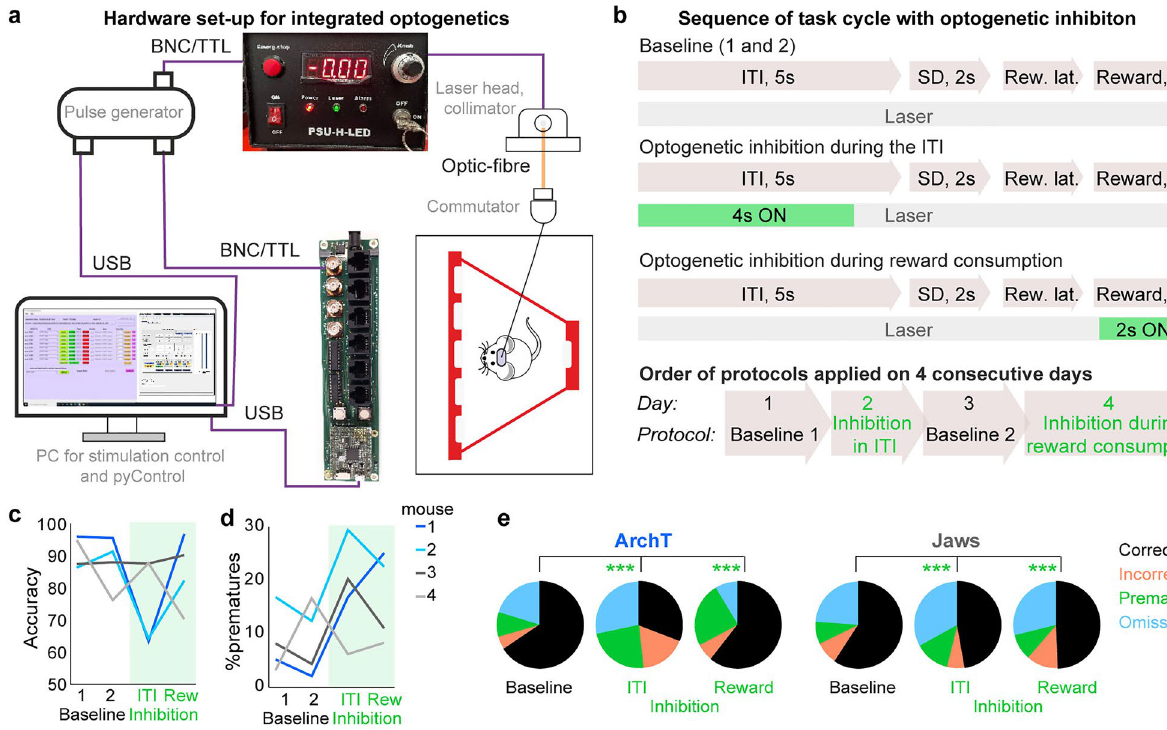
Figure 8. Integration of behavioural testing with optogenetics. ( a ) Wiring scheme for controlling a pulse generator and connected laser from pyControl through a BNC/TTL-output from the breakout board. (The hardware definition file for this arrangement is identical to that shown in Fig. 7b.) ( b ) 5-CSRTT task-cycles (illustrated for the case of a correct response) with either no optical stimulation (baseline sessions 1 and 2), unilateral optical modulation of the dHC during the first 4 s of the ITI or during the first 2 s of reward collection (from top to bottom). Below, the order in which the four protocols were conducted is shown. ( c,d ) Attentional accuracy (c) and premature responding (d) of each mouse (colour-code in d ); protocols with optical modulation indicated in green. Note that mice 1 and 2 were transduced with ArchT, while the remainder were transfected with Jaws. ( e ) Share of each of the four response options (colour code on the right) in the indicated condition (baseline sessions 1 and 2 merged); asterisks indicate chi-square test between baseline and each of the stimulation conditions. *** P <